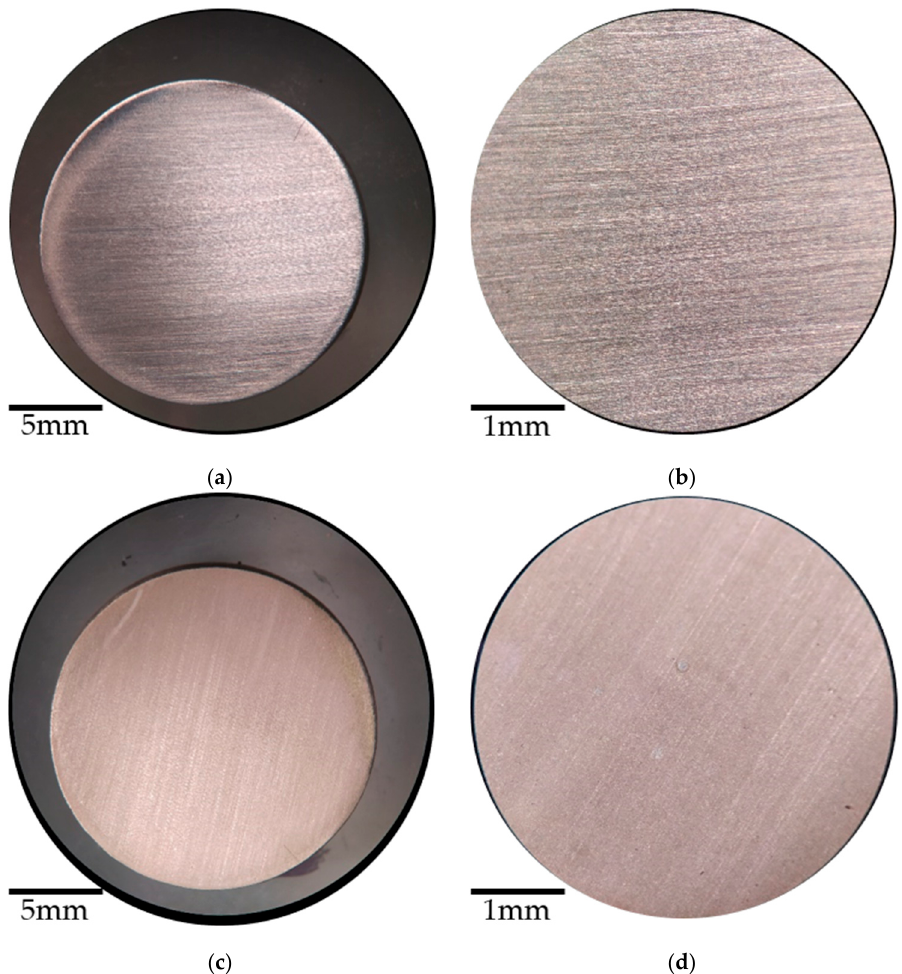
Figure 8. Micrographs before corrosion of structural steel ( a ) polished with magnification 1×, ( b ) polished with magnification 5×, ( c ) coated with magnification 1×, and ( d ) coated with magnification 5×.